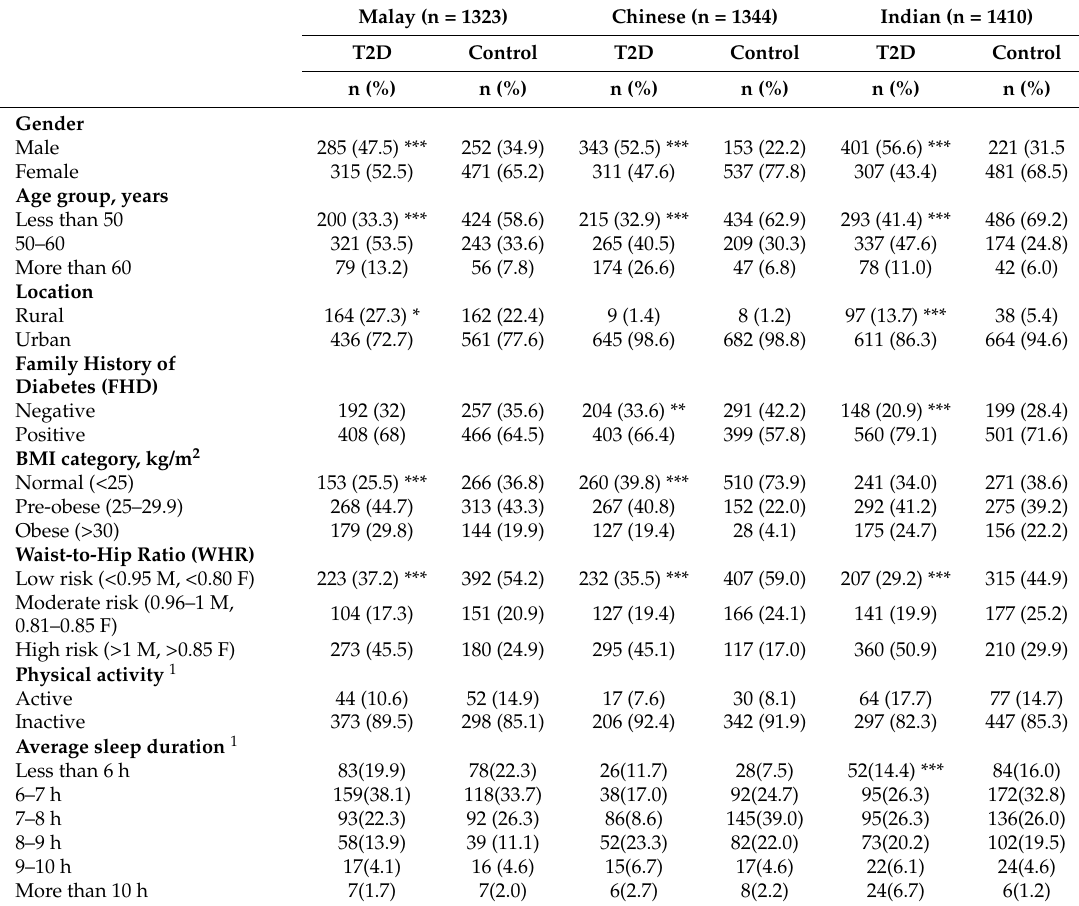
Table 1. Demographic and clinical characteristics of the Malaysian sample (n =